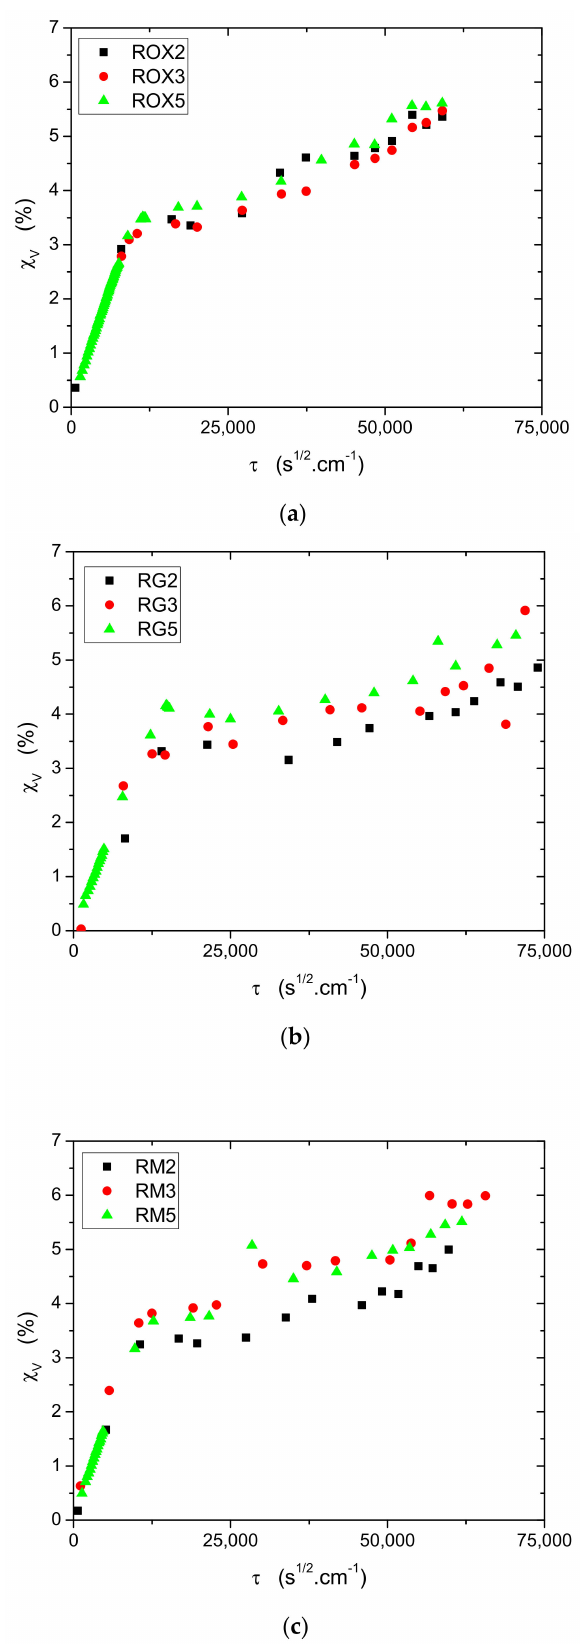
Figure 5. Evolution of the volume water uptake values with reduced time for ( a ) ROX system, ( b ) RG system, and ( c ) RM system during the immersion at 35 ◦ C in